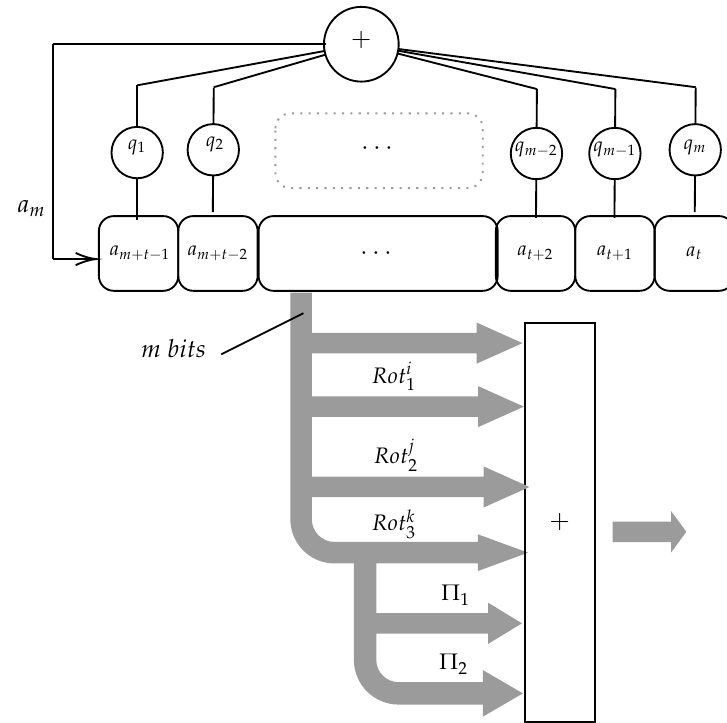
Figure 6. Improvements Gaussian generator based on LFSR